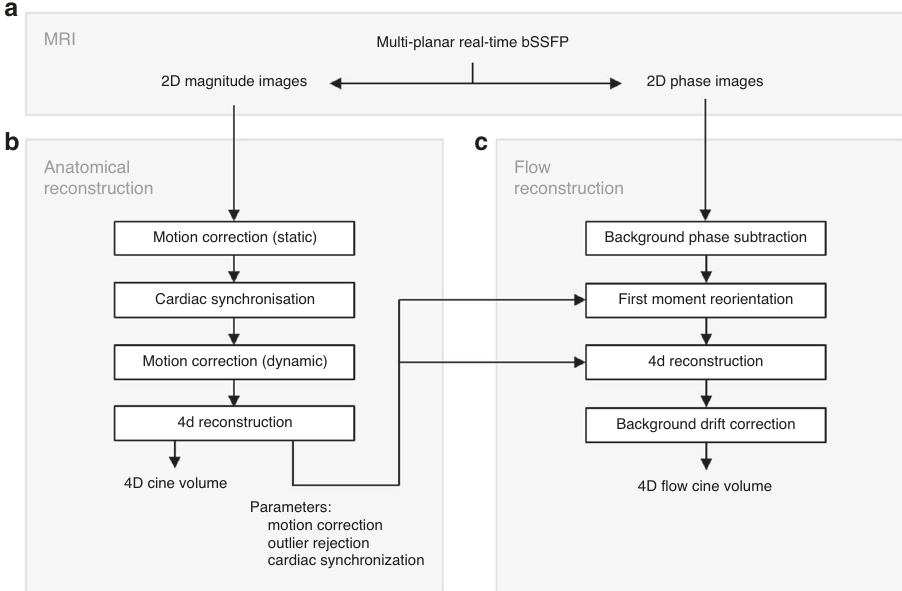
Fig. 8 Framework for 4D fl ow cine volume reconstruction. a Multi-planar dynamic bSSFP data is acquired and reconstructed into 2D magnitude and phase images using k – t SENSE. b Anatomical, volumetric 4D magnitude cine reconstruction of the fetal heart is performed 33 . c Volumetric 4D vector fl ow cine reconstruction of the fetal heart is performed, using motion correction, cardiac synchronization, and frame outlier rejection parameters from the magnitude reconstruction pathway. Background phase is estimated and subtracted by polynomial approximation. First moment vectors for the imaging gradients, as speci fi ed for the native acquisitions, are rotated as a result of detected motion. Velocity vector fi elds are recovered by inversion of the phase image information using a conjugate gradient method. Volumetric and temporal 4D reconstruction is performed before a fi nal background velocity drift correction is applied.